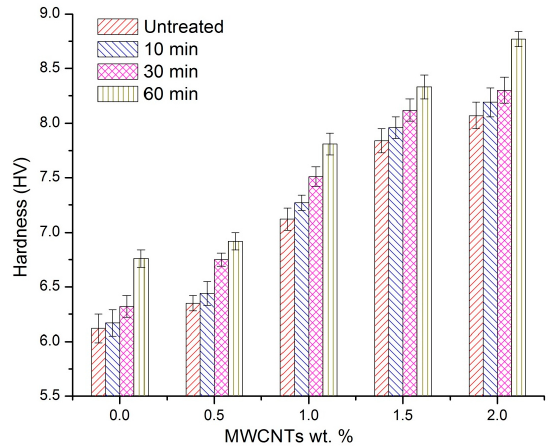
Figure 8. Variation of hardness of UHMWPE/MWCNTs nanocomposites under different treatment times.